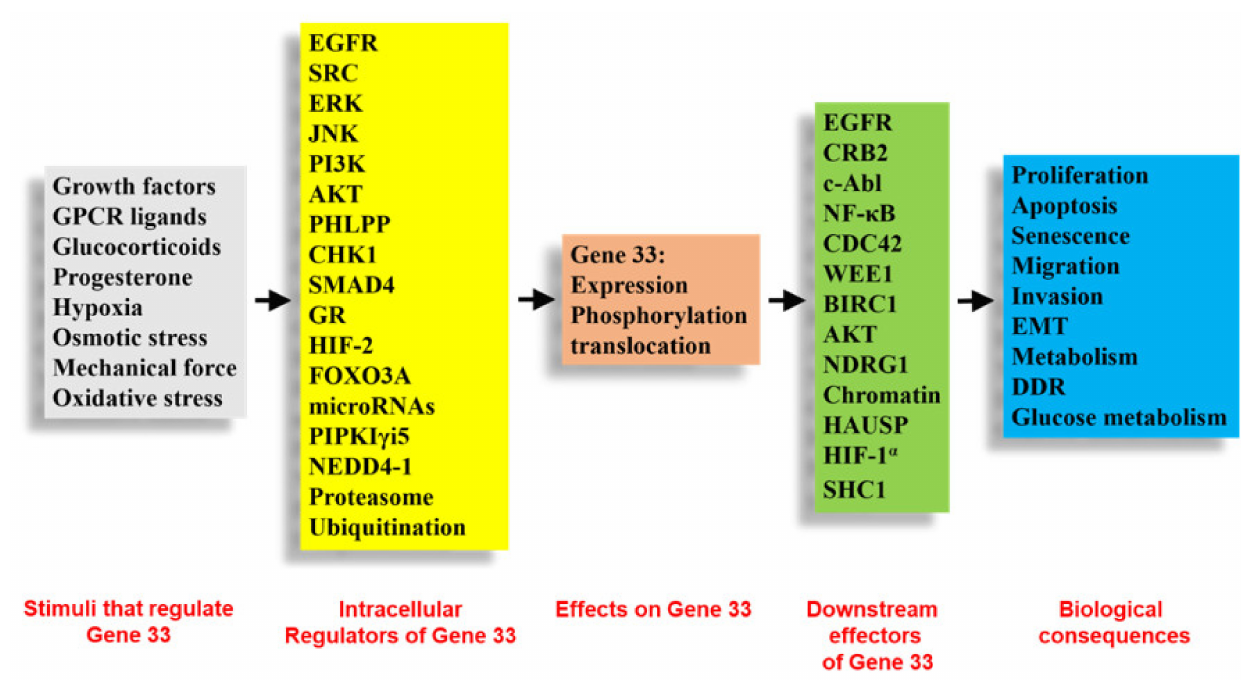
Figure 4. Summary of the known regulations and biological functions of Gene 33. Abbreviations: EMT: epithelial mesenchymal transition, DDR: DNA damage response. Other abbreviations are gene